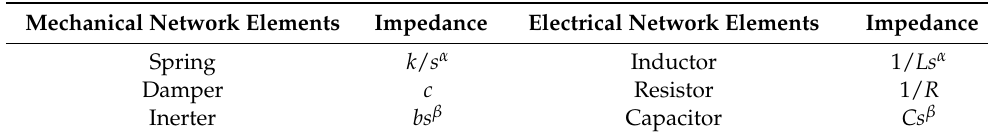
B ( s ) Figure 2. A quarter vehicle suspension model. Table 2. Parameters of quarter vehicle suspension model. Parameters